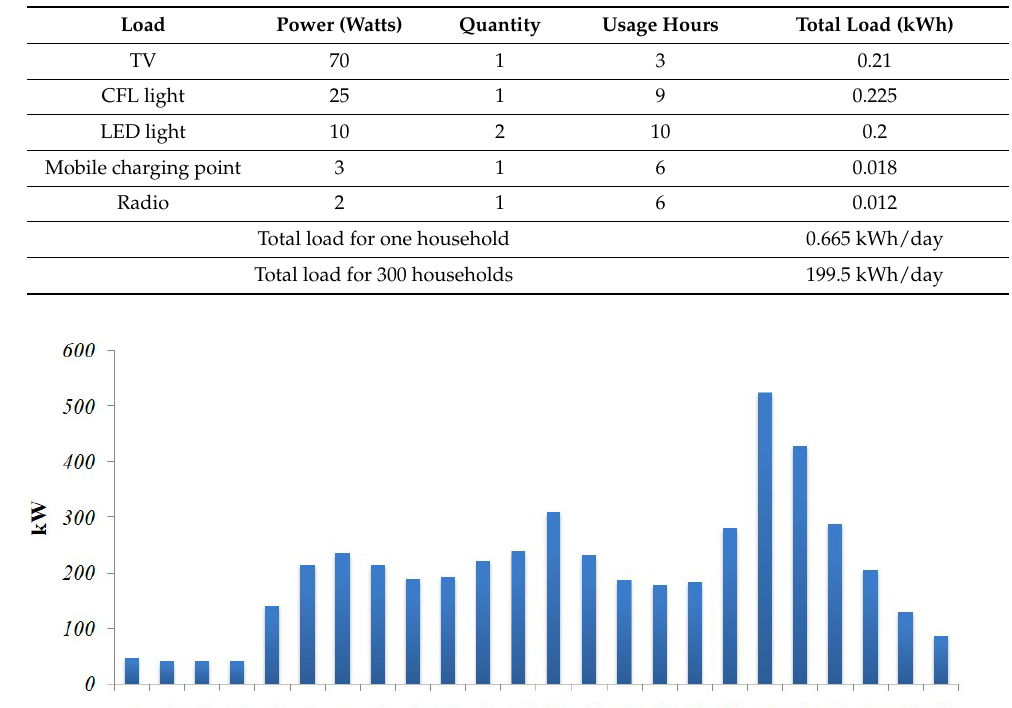
Table 1. Estimated electrical load in the residential community of Turtuk village, Ladakh.